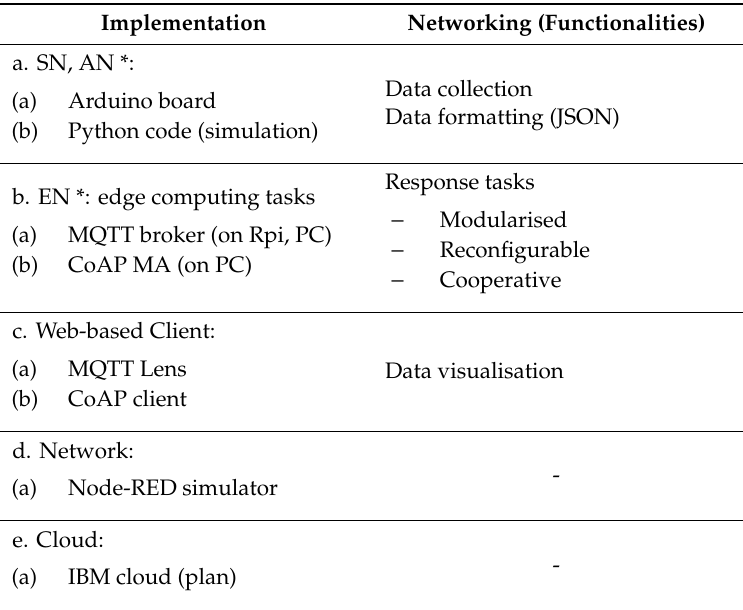
Table 2. Simulation platform and hardware.